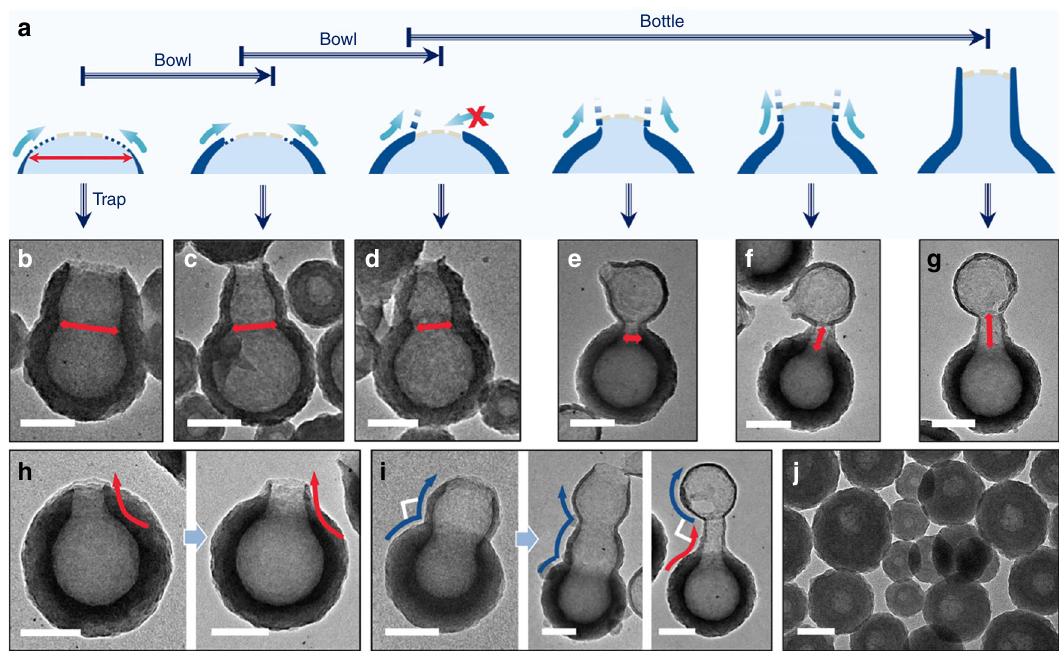
Fig. 4 Trapping intermediates with the second addition. a Schematics illustrating the process of shell extension. TEM images of b second addition products of nanobowls reacted for 6 h; c – e second addition products of nanobottles reacted for 3, 6, and 15 h, respectively; f , g typical long-neck cucurbits with different neck length; h gradual curve at the connecting point for bottlenecks vs. i sharp turn at the connecting point for nodes growth, and j second addition products of enclosed spheres reacted for 3 h. Scale bars are 100